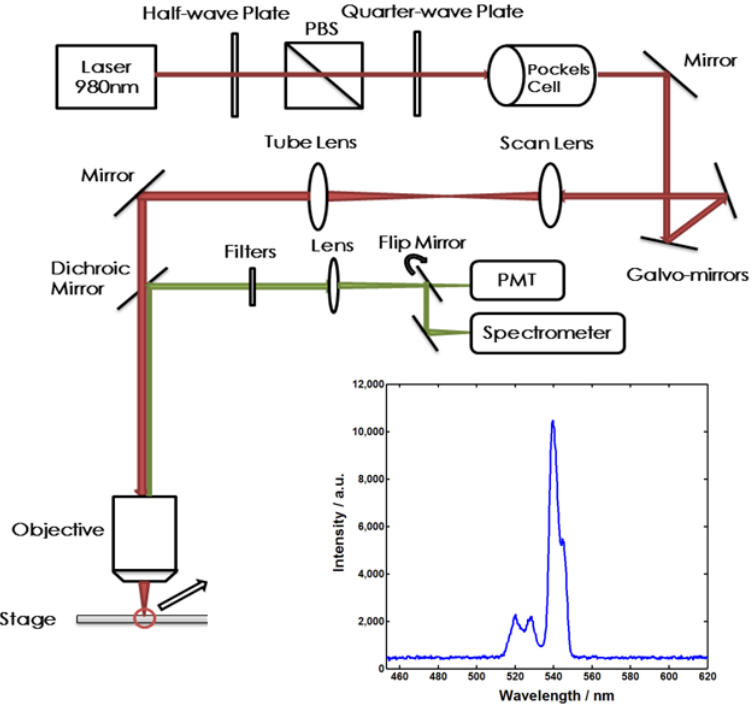
Fig. 1. Sketch of the custom-built microscope for measuring the luminescence properties of UCNPs. The inset shows the measured luminescence spectrum of Er3 þ and Yb3 þ co-doped CaF 2